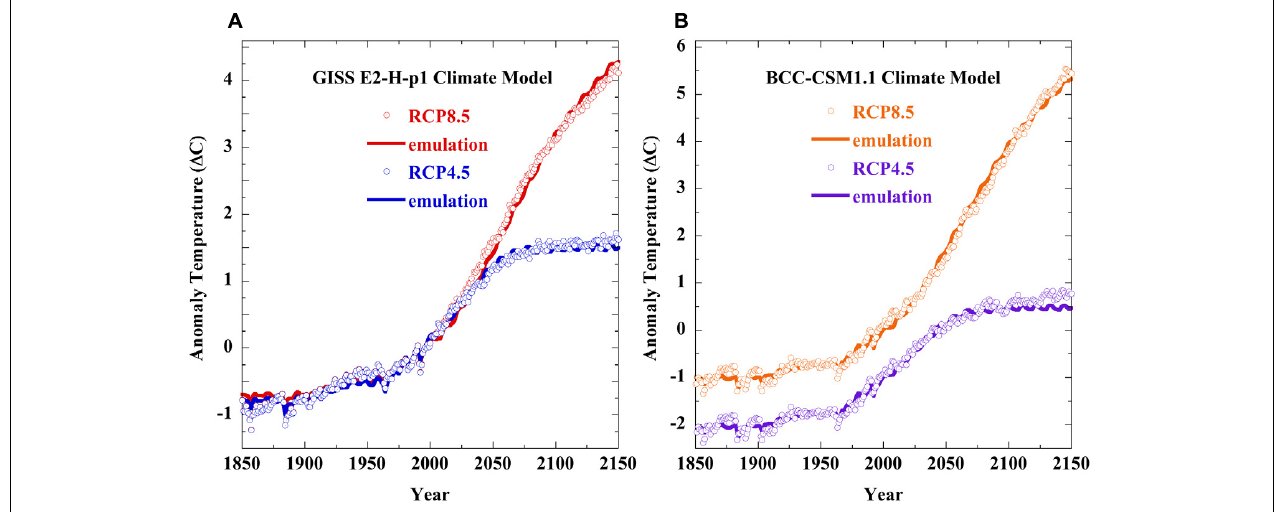
FIGURE 3 | Equation 1 emulation of CMIP5 RCP4.5 and RCP8.5 air temperature projections. Panel (A) (points), the GISS GCM Model-E2-H-p1, and; (lines), the emulations. Panel (B) (points), the Beijing Climate Center Climate System GCM Model 1-1 (BCC-CSM1-1), and; (lines), the emulations. In (B) , the vertical offset of RCP4.5 was present in the downloaded data. The equation 1 coefficients were ( f CO 2 , a ; RCP4.5 and RCP8.5): GISS: 0.578 ± 0.004, 20.0 ± 0.1, and; 0.488 ± 0.001, 16.93 ± 0.05; BCC: 0.636 ± 0.004, 23.2 ± 0.1, and; 0.680 ± 0.003, 23.7 ± 0.1, respectively. In (B) , the RCP4.5 emulation begins to depart from the GCM projection after 2050, when forcing becomes constant. The GISS and BCM models treat this region